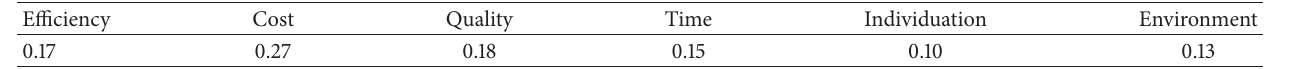
Table 10: The final weight of functional objectives on manufacturing